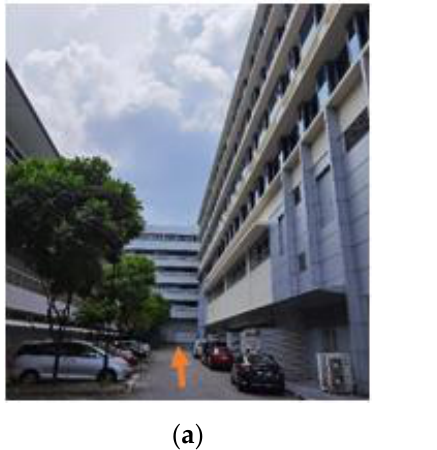
Figure 1. ( a ) Carpark F, NTU. ( b ) Flight Path at Carpark F.